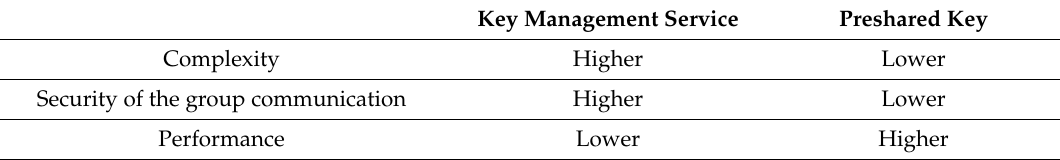
Table 2. Comparison between a Key Management Service and a preshared key to encrypt the group communication. Key Management Service Preshared